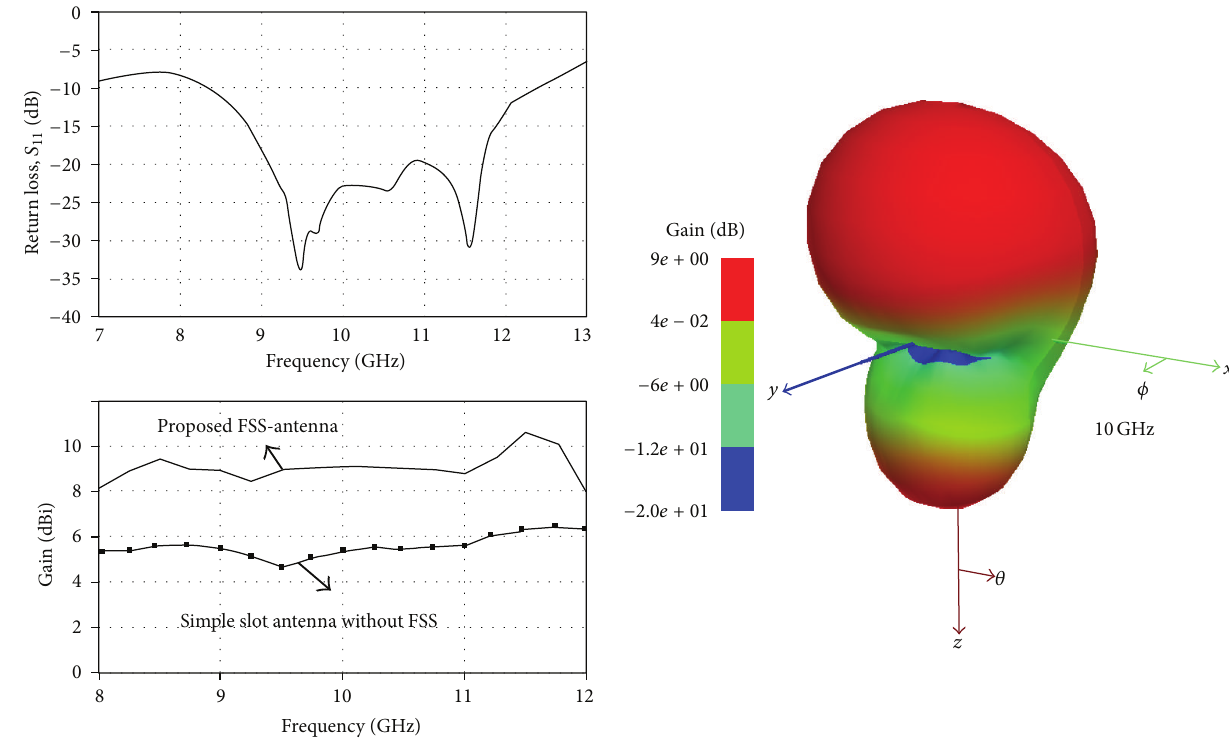
Figure 7: Gain, return loss, and 3D gain of the FSS-antenna, shown in Figure 6.